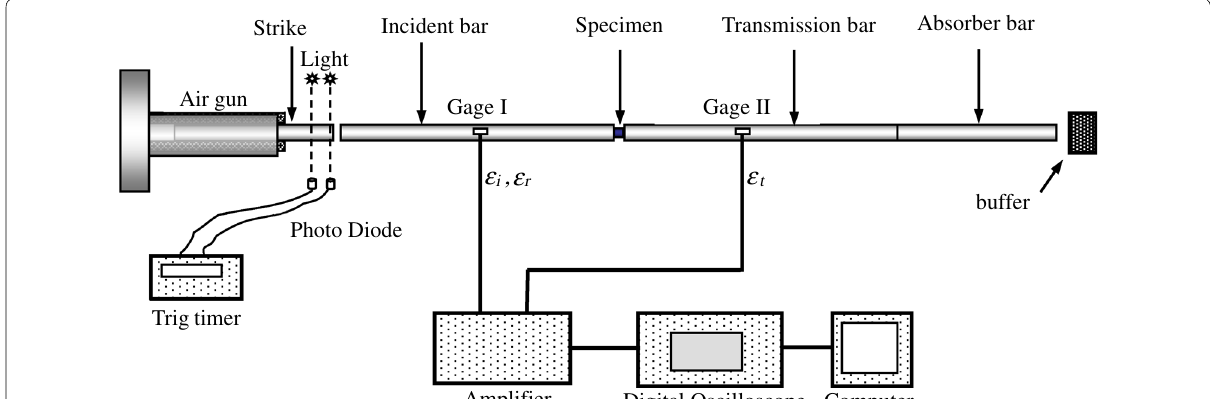
Fig. 2 Schematic design of SHPB